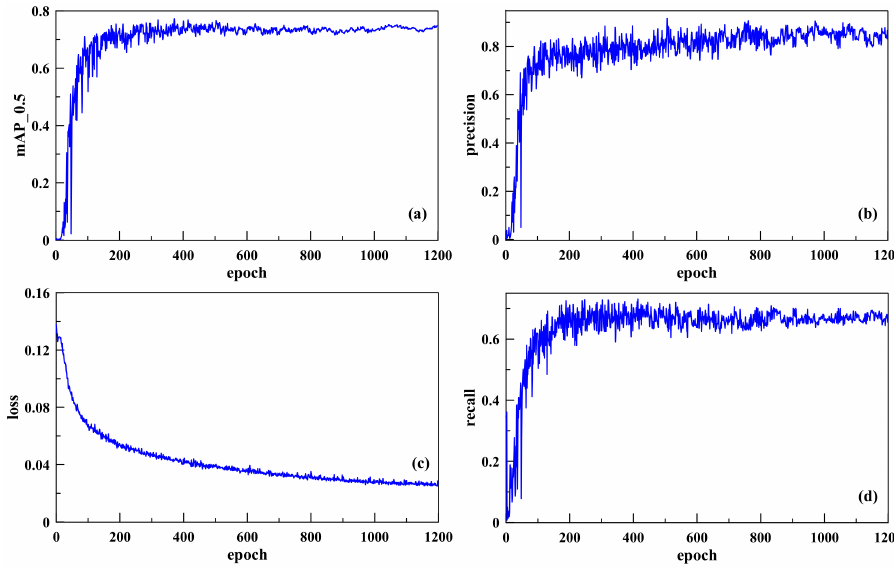
Figure 10. Performance and loss function of YOLOv5s. ( a ) mAP_0.5, ( b ) loss, ( c ) precision, ( d ) recall. After the training process, YOLOv5s trains the model using the testing dataset images which were not employed during the training. Each pothole is highlighted using a bound- ing box having a label presenting the value of its corresponding confidence as shown in Figure 11. The YOLOv5s model identifies defects on road surface with confidence values ranging from 0.56 to 0.93. It is noted that this model gets the error detection of pothole in some cases as a red circle marked in the images.